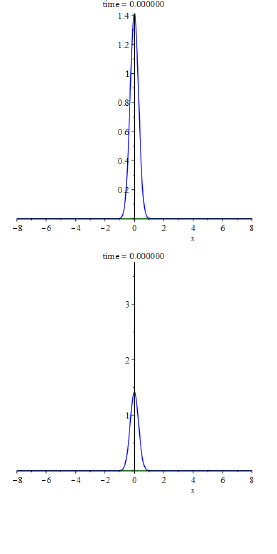
Figure 6. The figure illustrates propagating two waves due to the explosion of a smoothly localized unit mass of predators amid the uniform distribution of prey, the density of which is equal to the carrying capacity. The blue lines are for the instantaneous graphs of the predators’ density. The green lines are for the deviation of the prey density from the carrying capacity. The detailed description of the initial states and other settings used for computing this figure is in Appendix